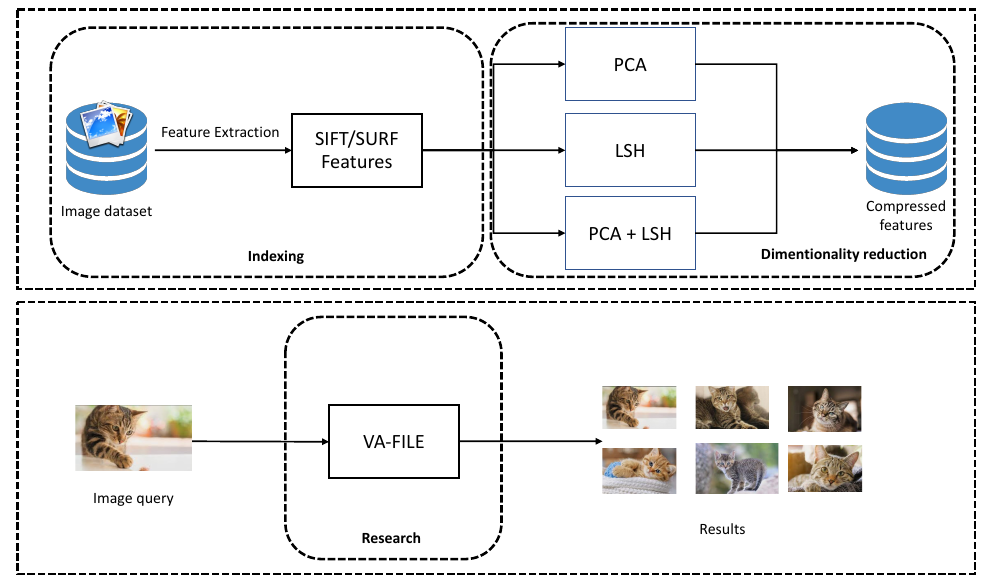
Figure 1. The general architecture of our proposed